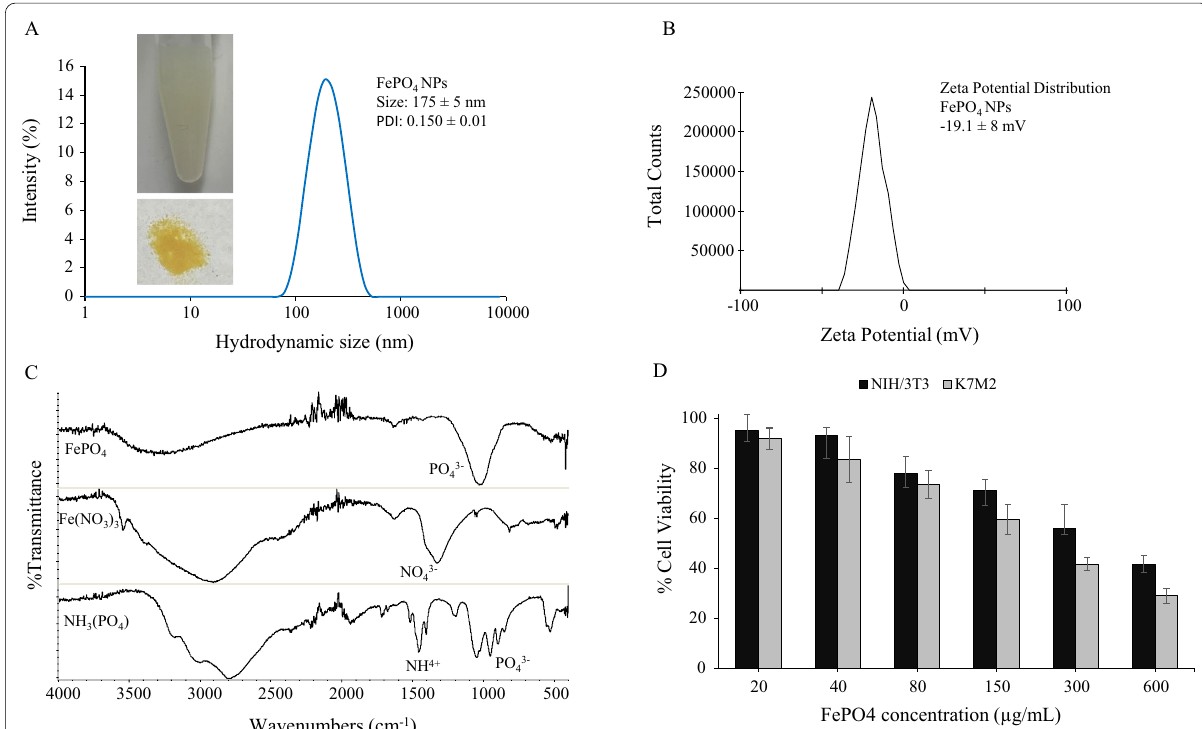
Fig. 1 Characterization and biocompatibility of FePO 4 nanoparticles. a Hydrodynamic size distribution of FePO 4 NPs, b zeta potential measurement of FePO 4 NPs showing the surface charge, c FTIR of FePO 4 NPs and its precursor-Fe(NO 3 ) 3 and (NH 4 ) 3 PO 4 , and d biocompatibility of FePO 4 NPs on mouse osteosarcoma K7M2 and mouse fibroblast NIH/3T3 cell line. NPs were treated at various concentrations for 48 h ( a, b data represents mean s.d.; n 3 replicates. d represents mean s.d., n 6 ± = ± =